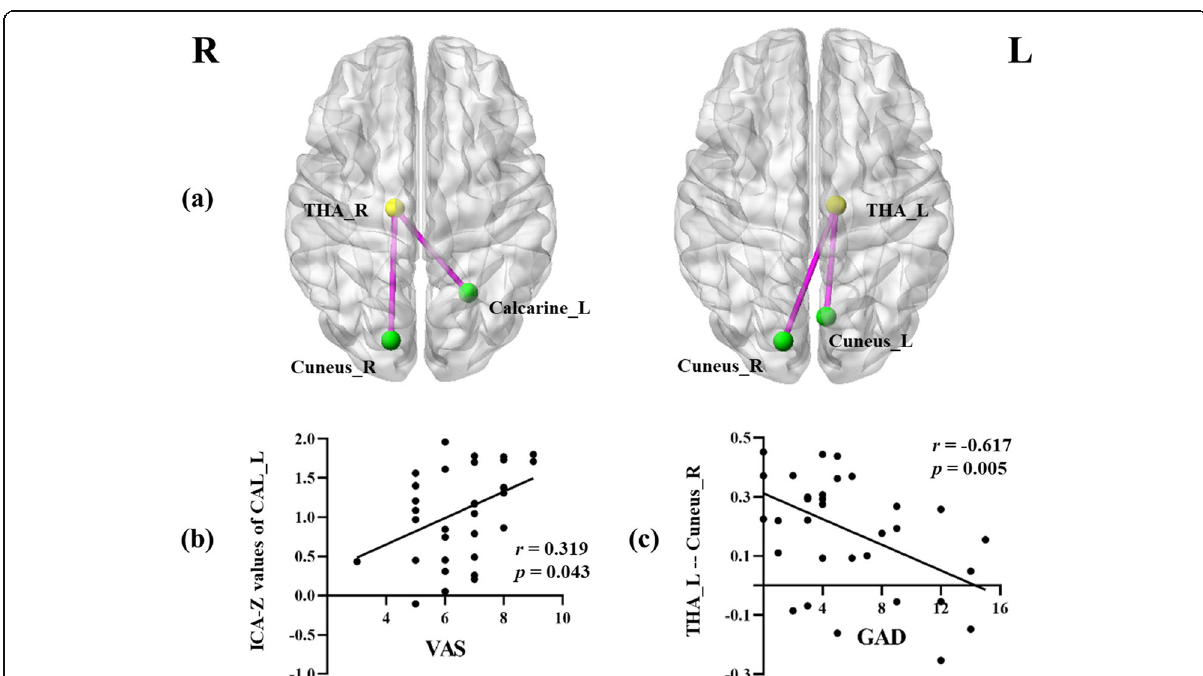
Fig. 3 Aberrant ROI-wise functional connectivity between the bilateral thalami and visual network in patients with MwoA compared with HC ( A ). The threshold was set at p < 0.001, uncorrected. The significant positively correlation between the ICA-Z values of the left calcarine sulcus and VAS scores ( B ). The significant negatively correlation between functional connectivity of the left thalamus to the right cuneus and GAD scores ( C ). THA: thalamus; CAL: calcarine; ICA: independent component analysis; VAS: visual analogic scale; GAD: generalized anxiety disorder; L: left; R: